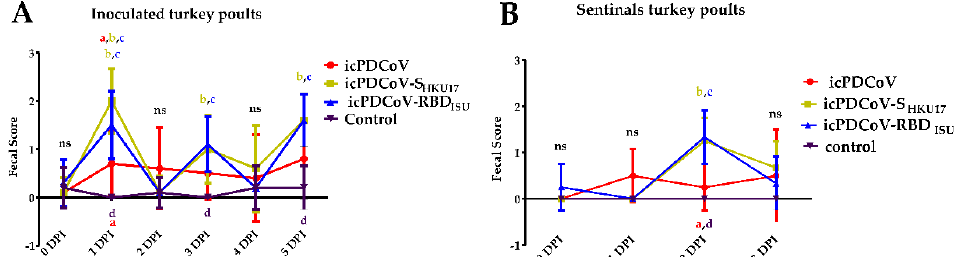
Figure 8. Fecal scores of turkey poults at 0- to 5-DPI. Fecal consistency was scored as follows: 0, normal; 1, pasty; 2, semiliquid; 3, watery), and the fecal score >2 was considered as diarrhea. Red circles, green squares, blue triangles, and black triangles represent ( A ) icPDCoV-inoculated, icPDCoV-S HKU17 -inoculated, icPDCoV-RBD ISU -inoculated, and control groups ( n = 10 biologically independent samples). ( B ) sentinel poults that commingled at 1 DPI ( n = 4 biologically independent samples), respectively. Different lower-case letters (a; icPDCoV, b; icPDCoV-S HKU17 , c; icPDCoV-RBD ISU , d; mock) indicate significant differences between the given group at each time point. Significant diarrhea for each test virus was only observed at day 1 post infection but for groups icPDCoV-S HKU17 and icPDCoV-RBD ISU diarrhea was also observed on days 3 and 5 in inoculated birds and day 2 in sentinel birds. Two-way ANOVA with Bonferroni post hoc test, p ≤ 0.05. ns, not statistically significant.